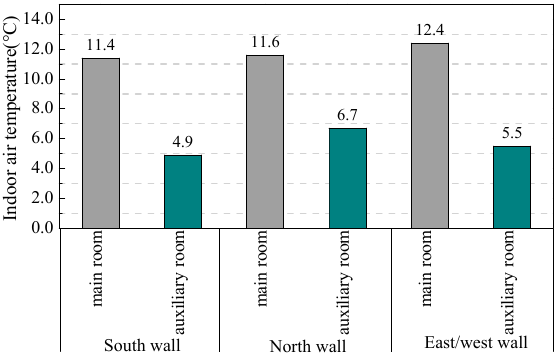
Figure 14. Indoor air temperatures of the main and auxiliary rooms with maximum thermal resistance of exterior walls.